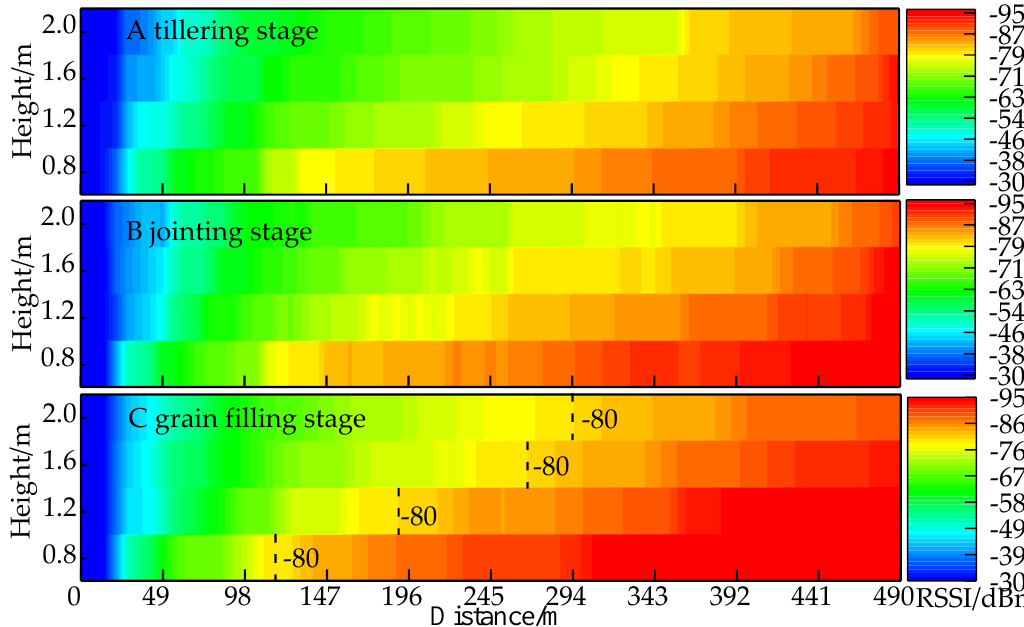
Figure 3. Corresponding channel path loss at different antenna heights in the ( A ) tillering stage; ( B ) jointing stage; and ( C ) grain filling stage.